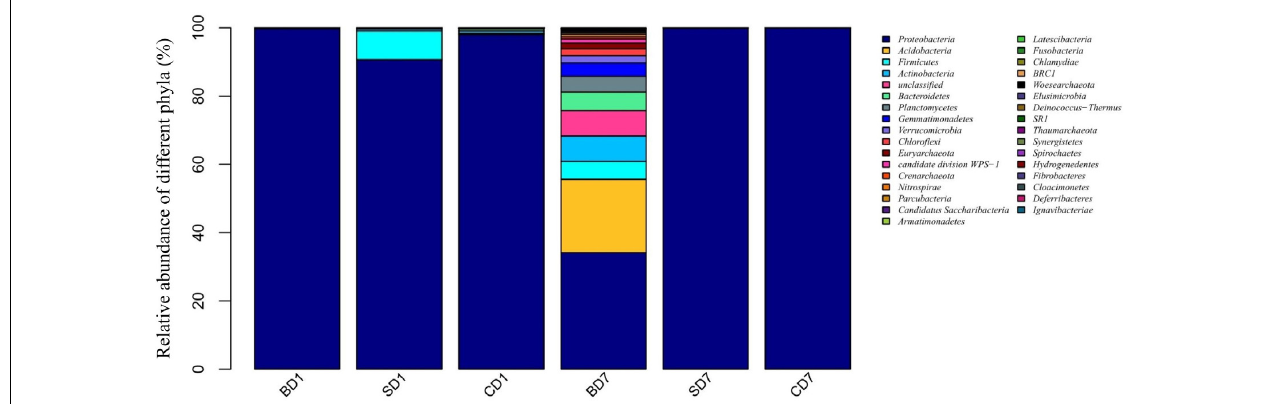
FIGURE 1 | Relative abundance of different bacterial phyla within PL microbiota in BD, SD, and control (CD) groups. This distribution bar plot was drawn with R software. BD1, SD1, and CD1 represent PL samples at day 1 of the test, and BD7, SD7, and CD7 represent PL samples at day 7.